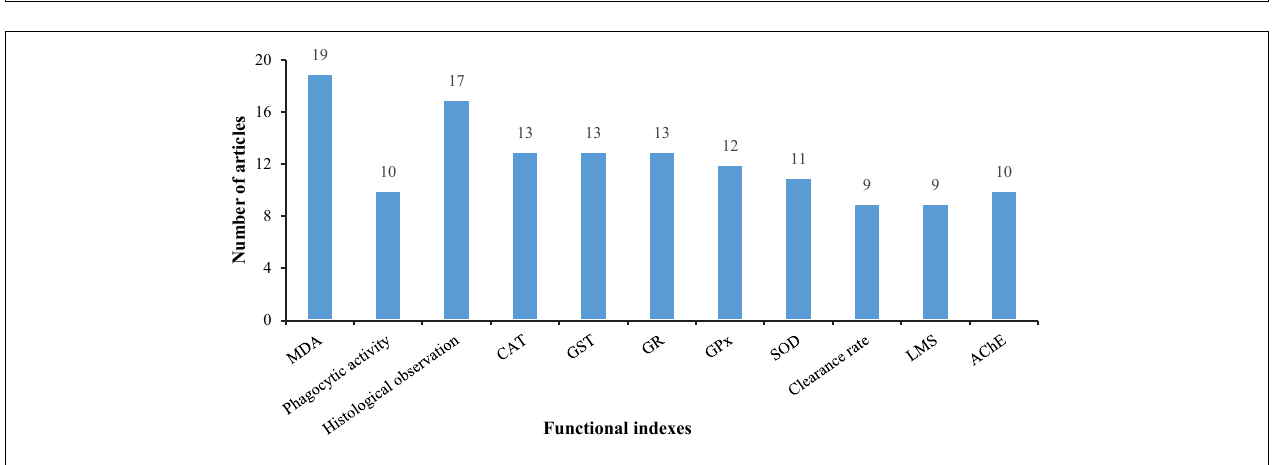
FIGURE 5 | The number of articles on the toxicological responses in mollusks exposed to microplastic.